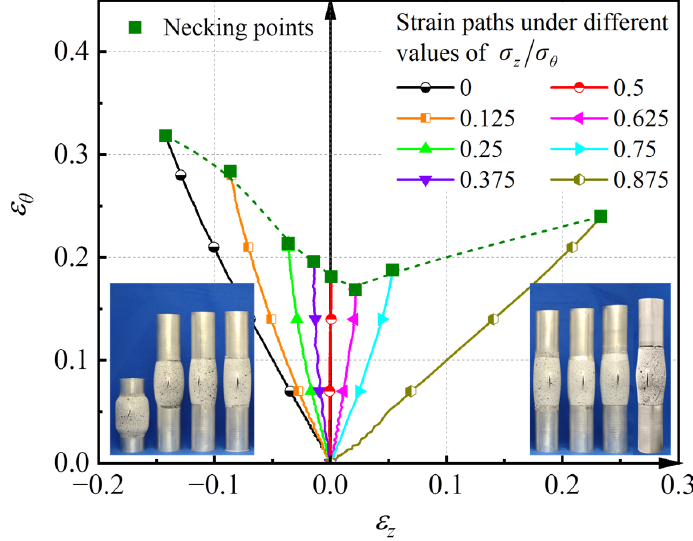
Figure 7. Necking points and strain paths of the AA6061 tube under linear loading paths.